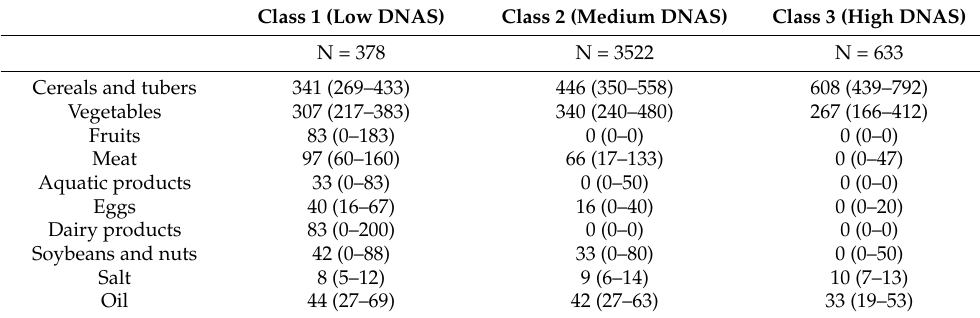
Table A1. Food intake (gram/day) at baseline by class identified by latent class trajectory